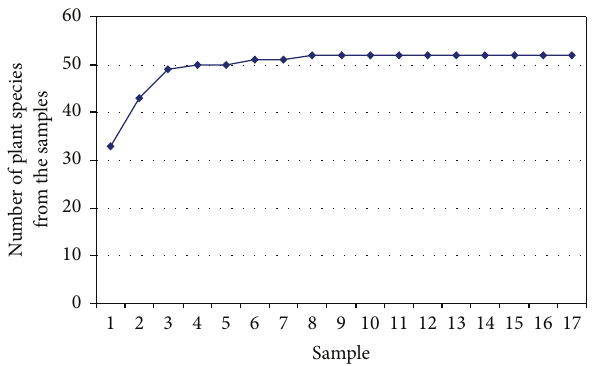
Figure 4: Plant species accumulation curve based on number of analyzed